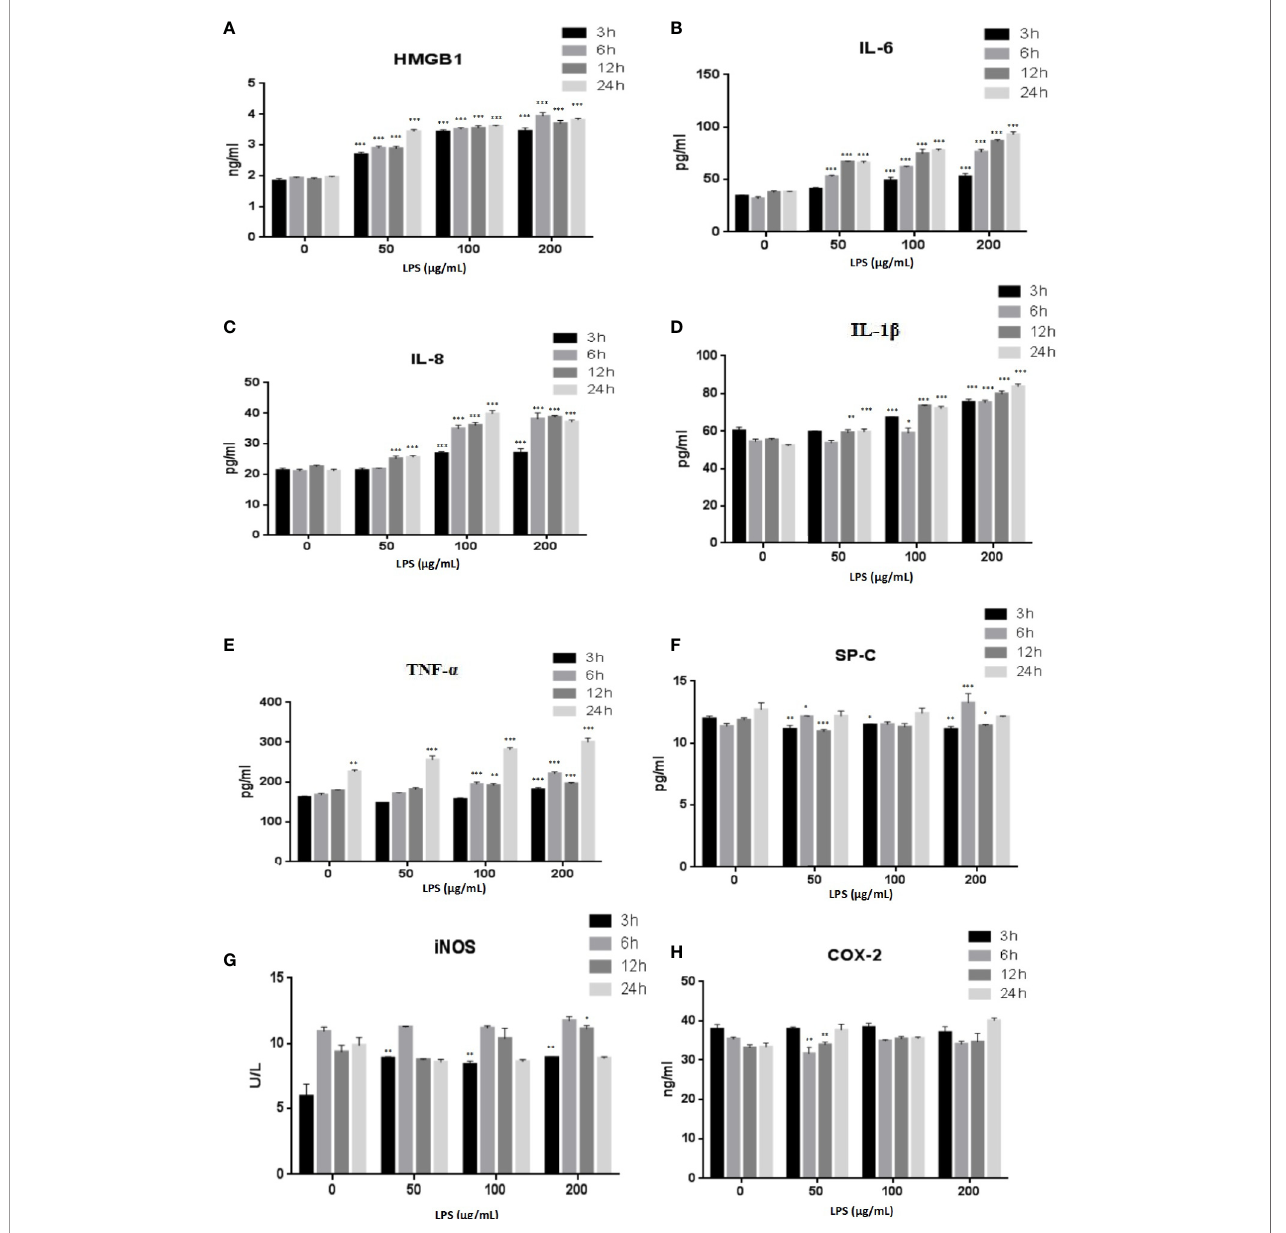
FIGURE 3 | LPS induced release of the in fl ammatory cytokines HMGB1 (A) , IL-6 (B) , IL-8 (C) , IL-1 b (D) , TNF- a (E), SP-C (F) , iNOS (G) , and COX-2 (H) from A549 cells. *p < 0.05, **p < 0.01, and ***p < 0.001 compared with the control group. Graphs show the mean ± SD of triplicate wells and represent three independent